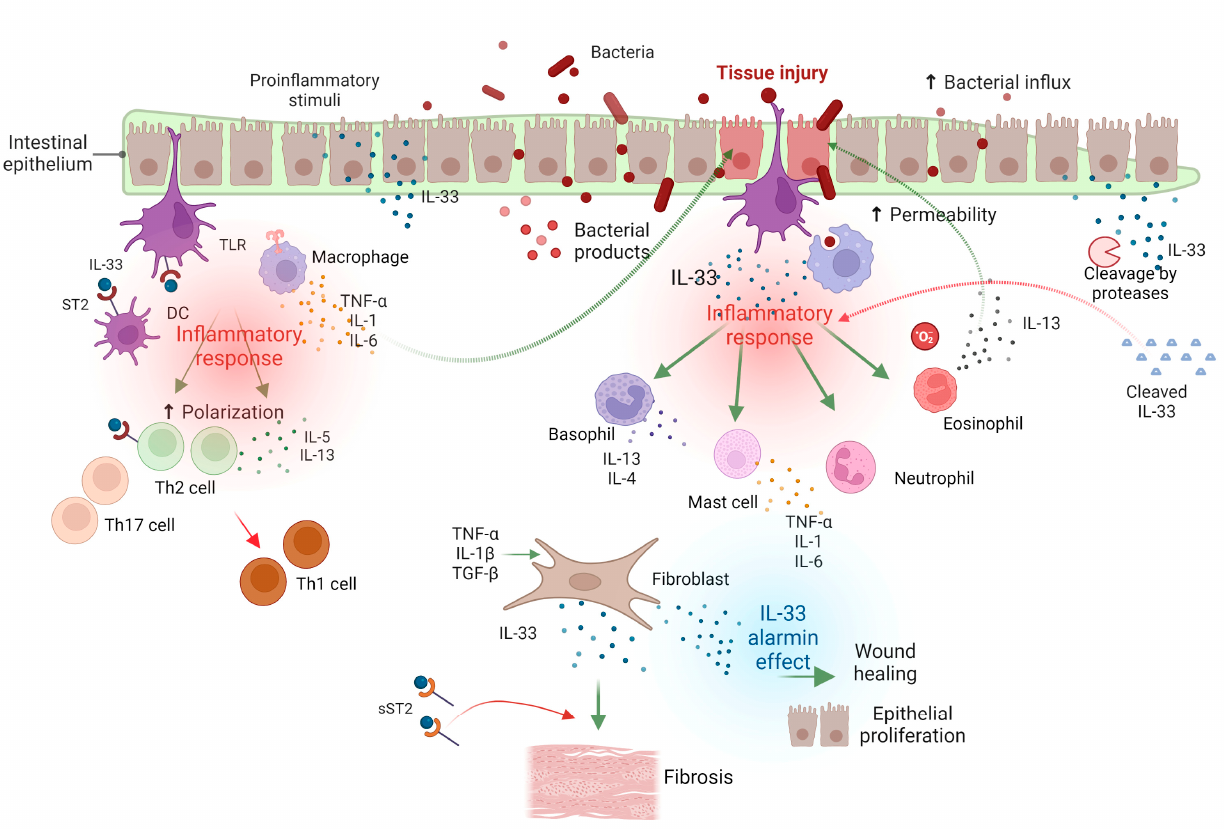
Figure 3. Role of IL-33/ST2 signaling pathway in inflammatory bowel disease pathogenesis. The intestinal epithelium of IBD patients is more exposed to pathogenic microorganisms, as the mucus layer is not able to obstruct pathogens’ access to the intestinal barrier, inducing epithelial impair- ment. In parallel, tissue damage can be provoked by infection or microbiota accumulation, which are also associated with IBD development. Epithelial damage results into the release of IL-33 from epithelial cells, inducing an inflammatory response. The activation of TLRs on the surface of mac- rophages leads to the secretion of proinflammatory cytokines, such as IL-6, TNF- α , and IL-1, which further induce epithelial injury. The presence of proinflammatory stimuli may also increase the in- tracellular IL-33 expression of intestinal epithelial cells. IL-33 activates the ST2-expressing cells to produce proinflammatory cytokines. IL-33 causes a polarization toward Th2 and Th17 immune re- sponses. Eosinophil activation by IL-33 leads to IL-13 secretion, exerting detrimental effects on epi- thelial barrier integrity. Myofibroblasts in the intestinal tissue have also been reported as an IL-33 source in IBD. The mast cell-mediated inflammatory response may lead to fibroblasts proliferation toward fibrogenesis. However, the presence of sST2 could counteract the IL-33 cellular effect. IL-33, acting as alarmin in response to cellular stress induced by the mucosal breach, has also been shown to induce epithelial proliferation, repairing the epithelial barrier, and promoting wound healing. Biologically active IL-33 can be cleaved by proteases within the intestinal mucosa, alleviating the proinflammatory outcomes of IL-33. This figure was created with BioRender (https://biorender.com (29 November 2022)). IL-33, interleukin-33; ST2, suppression of tumorigenicity 2; DC cells, dendritic cells; TLR, Toll-like receptor; TNF- α , tumor necrosis factor α ; Th1, T helper 1; TGF- β , transforming growth factor-beta; sST2, soluble ST2. The role of IL-33 in IBD presents complexity; the divergent pathophysiology of the immune responses in IBD may account to some extent for this complexity. The immuno- logical polarization of IBD has been classified as Th1- or Th2-related [46,47]. UC is related to a Th2 polarization [48], in contrast to CD, which has been associated with Th1 and Th17